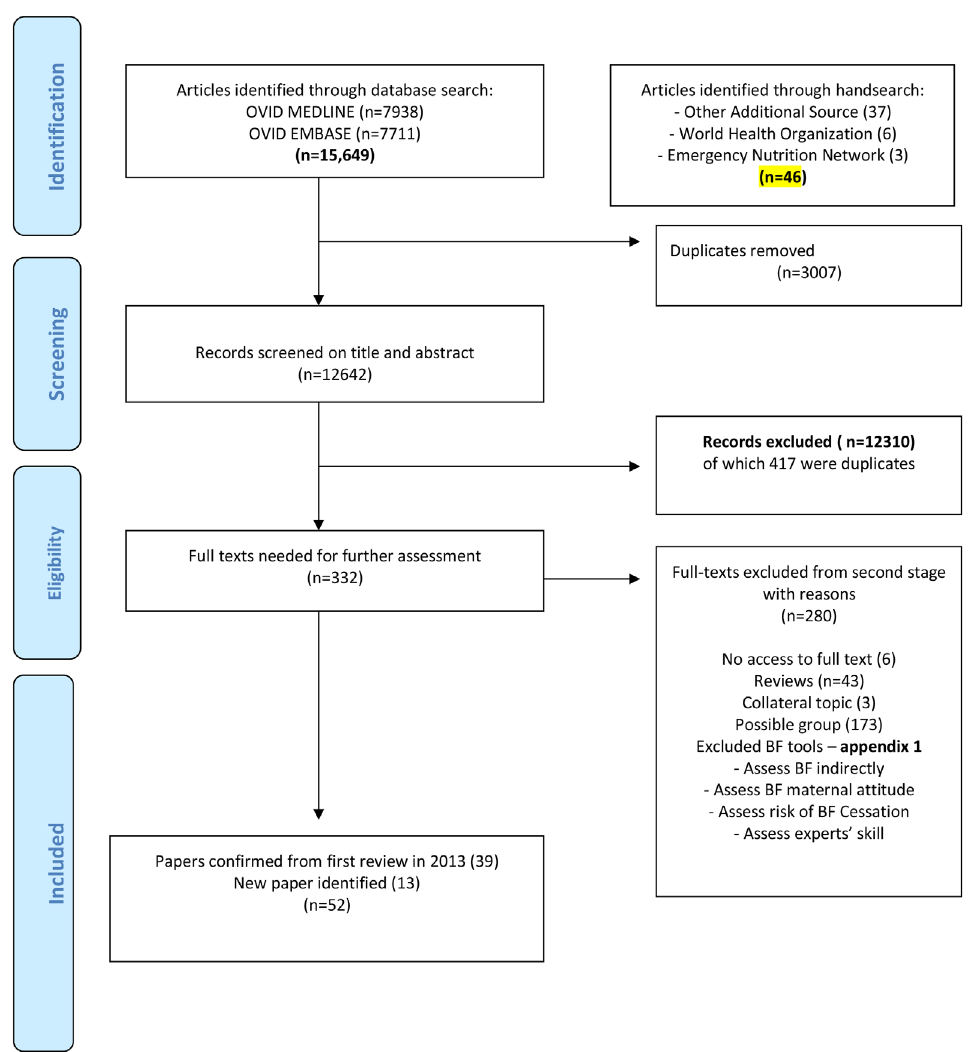
Figure 1. PRIMA Flow diagram: Systematic search for BreastfFeeding Assessment Tools Review. Preferred Reporting items for Systematic Reviews and Meta-Analyses (PRISMA) diagram of literature search results. Diagram retrieved from: http://prisma-statement. org/PRISMAStatement/FlowDiagram.asp x